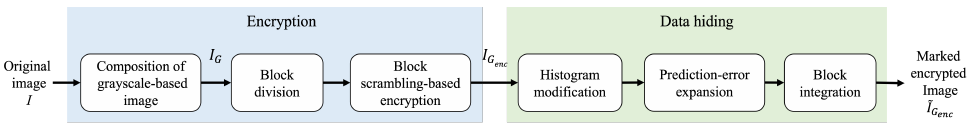
Figure 5. Encryption and data-hiding procedure of proposed